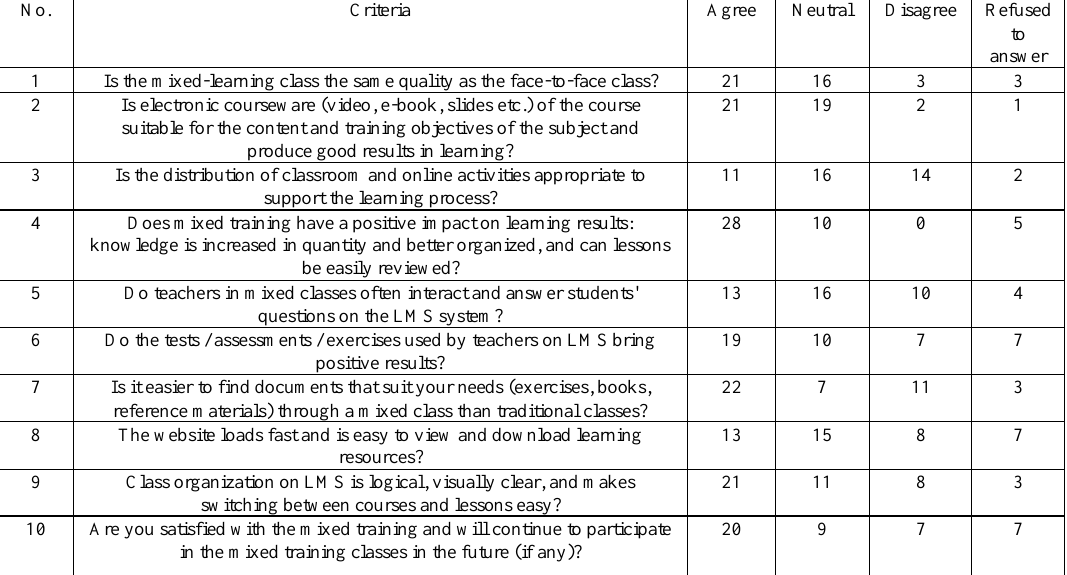
Table 4. Course evaluation